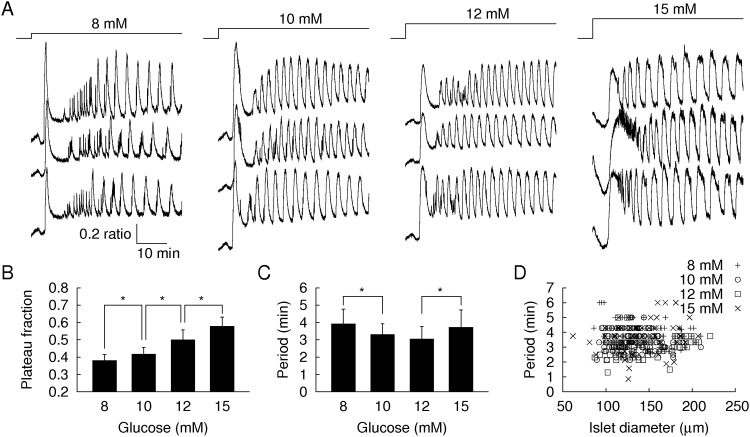
Glucose-dependent Ca2+ oscillations.(A) Time traces of the intracellular Ca2+ concentrations (340/380 nm fluorescence ratio) within each islet for 8, 10, 12, and 15 mM glucose concentrations and stimulation from the basal concentration of 3 mM. (B) Plateau fractions, ratio of active to silent phases, and (C) dominant periods of the Ca2+ oscillations (n = 99, 94, 64, and 64 islets for 8, 10, 12, and 15 mM glucose, respectively). Error bars represent standard deviations. *P<0.01. (D) Dominant periods versus islet diameters.